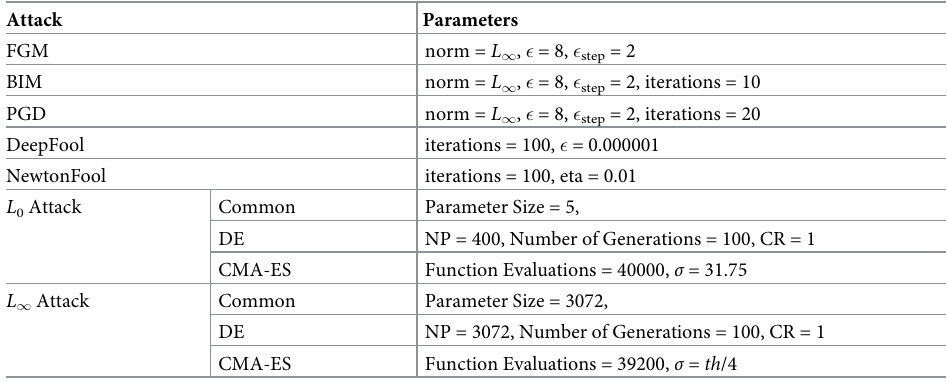
Table 3. Description of various parameters of different adversarial